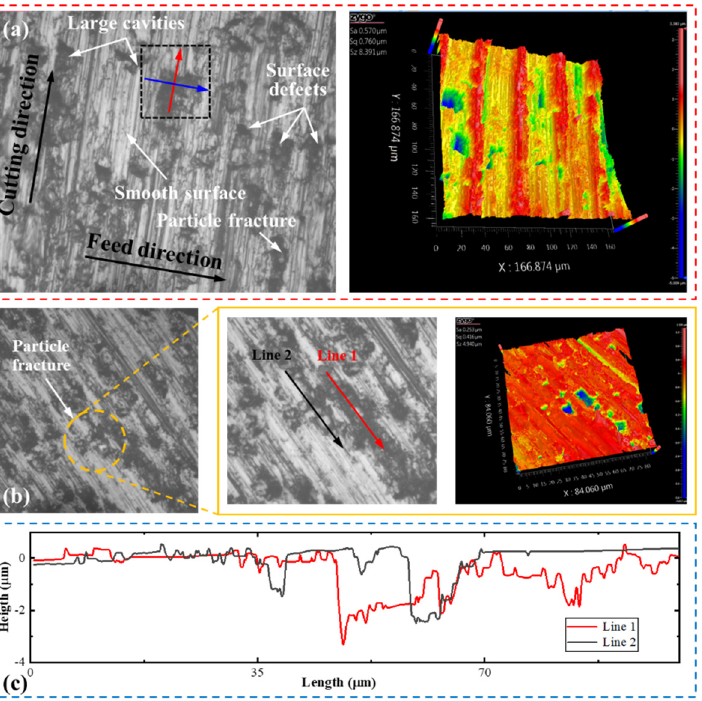
Figure 15. Micrographs of machined surface under a cutting depth of 25 μ m and a cutting speed of 250 mm/s. ( a ) surface defects; ( b ) particles embedded in matrix; ( c ) cross section morphology of embedded particles.